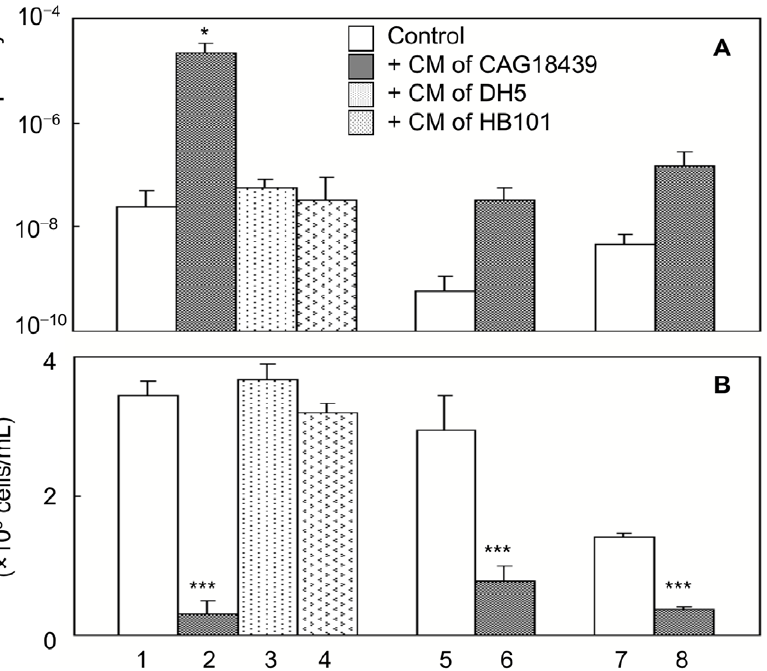
Figure 3. Effects of media conditioned with various strains on cell-to-cell transformation and on cell growth. Effects of media conditioned with CAG18439, DH5 and HB101 on cell-to-cell transformation (A) and on cell growth (B). Cell-to-cell transformation was performed in the presence or absence of 50% (v/v) conditioned medium (CM) of each strain indicated in the figure (lanes 1–4, co-culture of MG1655 harbouring pHSG299 and MC4100; lanes 5 and 6, co-culture of DH5 harbouring pHSG299 and MC4100; lanes 7 and 8, co-culture of MG1655 harbouring pHSG299 and MG1655 harbouring pGBM1). Data are presented as mean and S.D. (*: t -test: P , 0.05, n =4; { : t -test: P , 0.005, n =4; compared with control). doi:10.1371/journal.pone.0016355.g003 PLoS ONE |